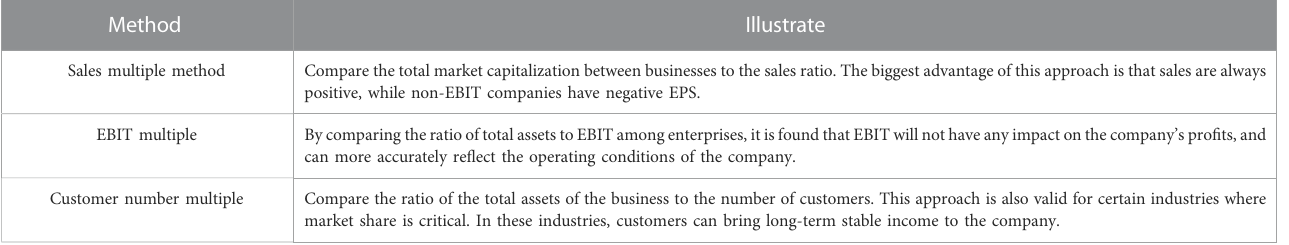
Customer number multiple